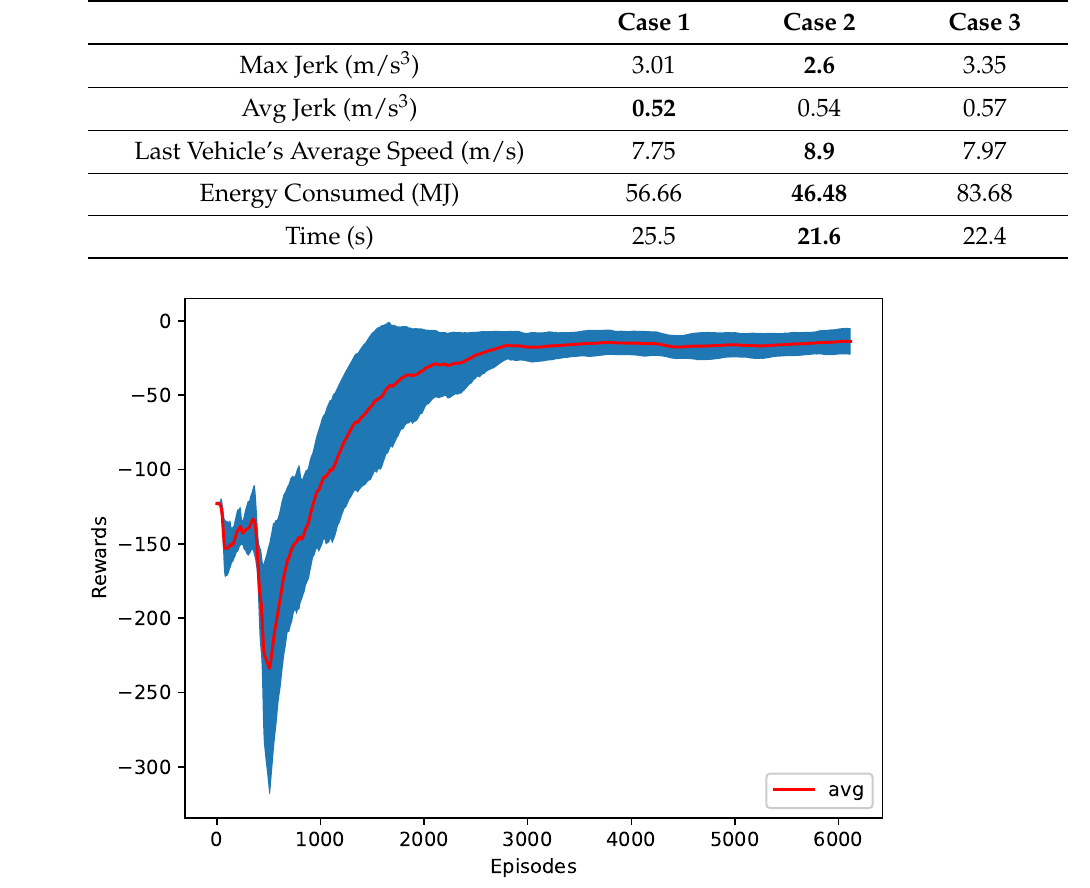
Table 4. Evaluation results of the multi-objective RL with different weights.